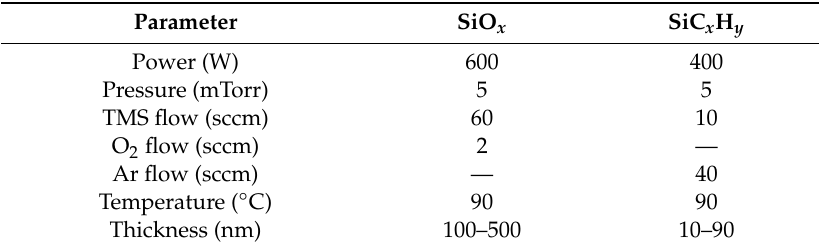
Table 1. Deposition parameters for SiO x and SiC x H y thin